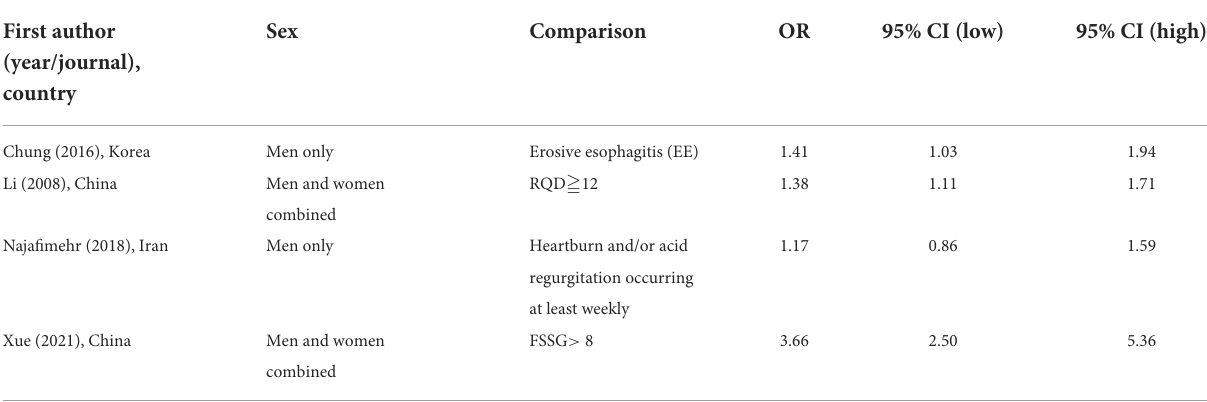
TABLE 2 Measures of the association between shift work and possible GERD used in four